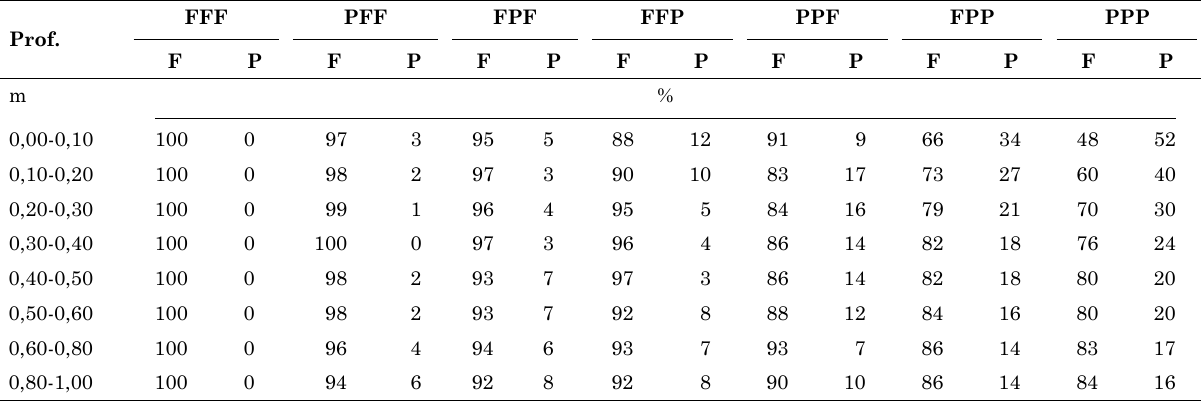
FFF: uso com floresta a mais de 70 anos; FPF: área ocupada nos últimos 25 anos por floresta, antecedida por um período de 25 anos por pastagem e anteriormente por floresta; PFF: uso com florestas nos últimos 50 anos e pastagem no período anterior a 1957; PPF: área ocupada nos últimos 25 anos com floresta, antecedida por pastagem; PPP: uso com pastagem a mais de 70 anos; FFP: uso com pastagem nos últimos 25 anos; e FPP: uso com pastagem nos últimos 25